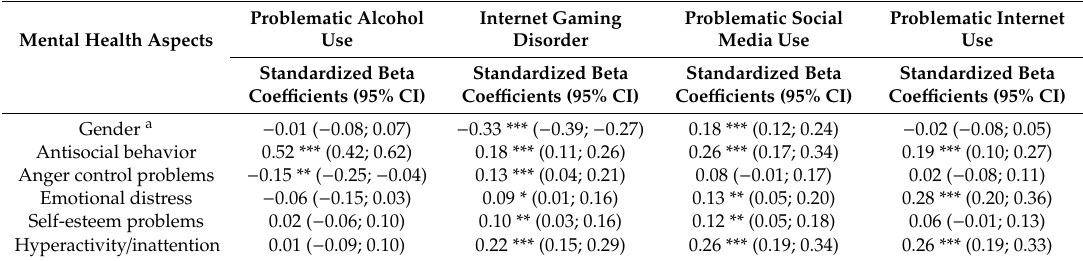
Table 3. Multiple linear regression models regarding the associations between mental health aspects and problematic alcohol use, problematic gaming behavior, problematic social media use and problematic Internet use in